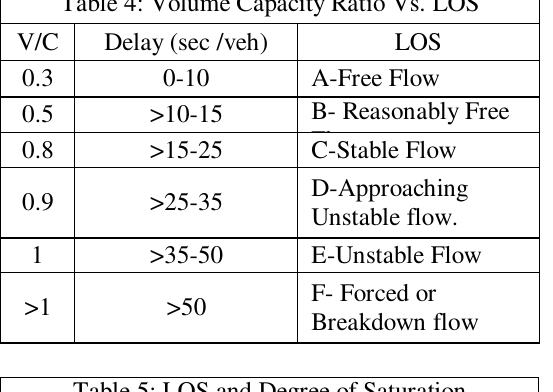
Table 5: LOS and Degree of Saturation Sr.